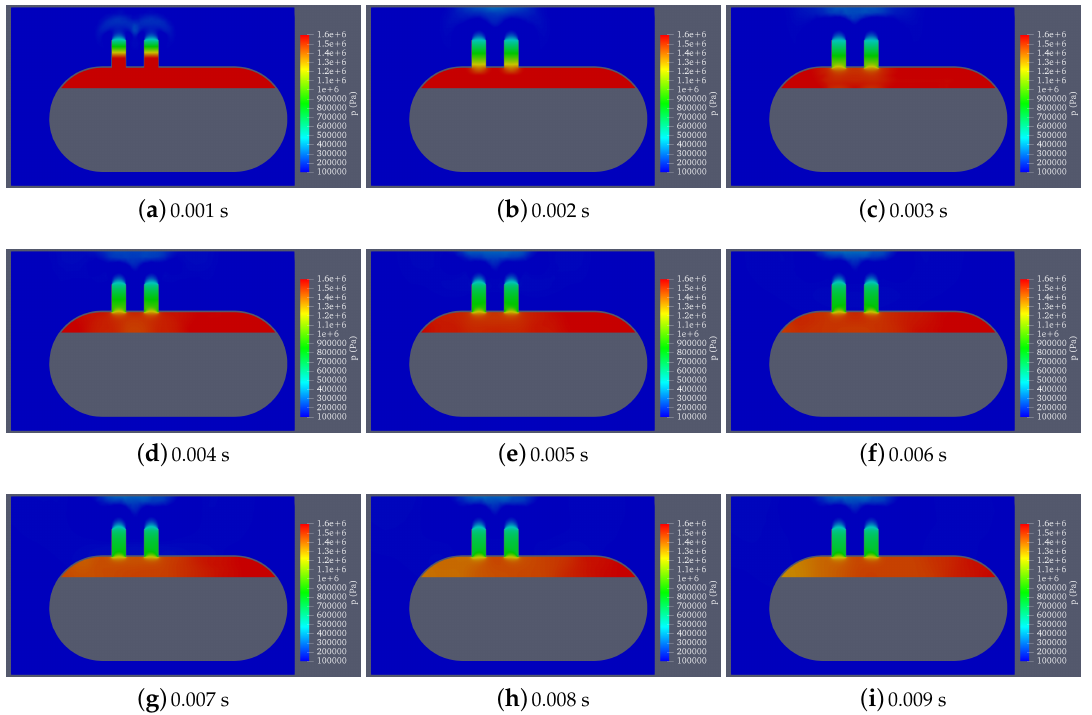
Figure 13. The distribution of pressure of the simulation results of the SST k - ω model by using PRTFOAM at different times from ( a ) 0.001 s to ( i ) 0.009 s with interval ∆ t = 0.001 s (legend unit: Pa).